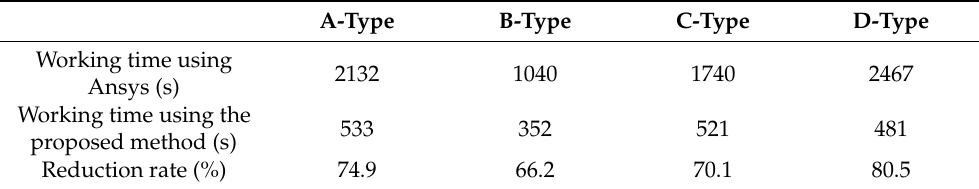
Table 8. Evaluation of reduction in working time for optimal CFD model design.